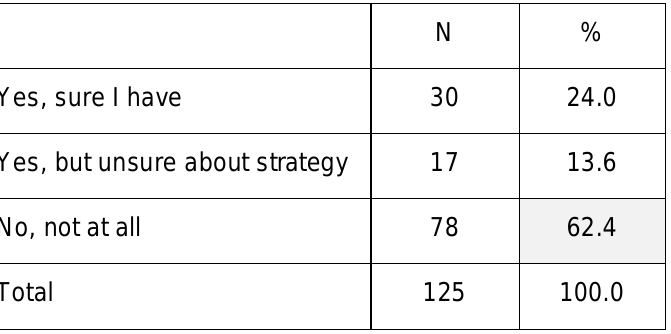
Table 1: Thinking of harvesting strategy when starting the